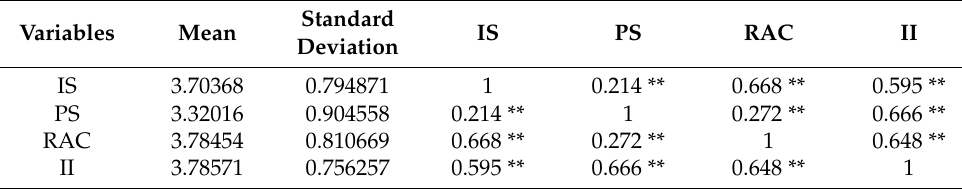
Table 4. Descriptive statistical analysis and correlation matrix of each variable.